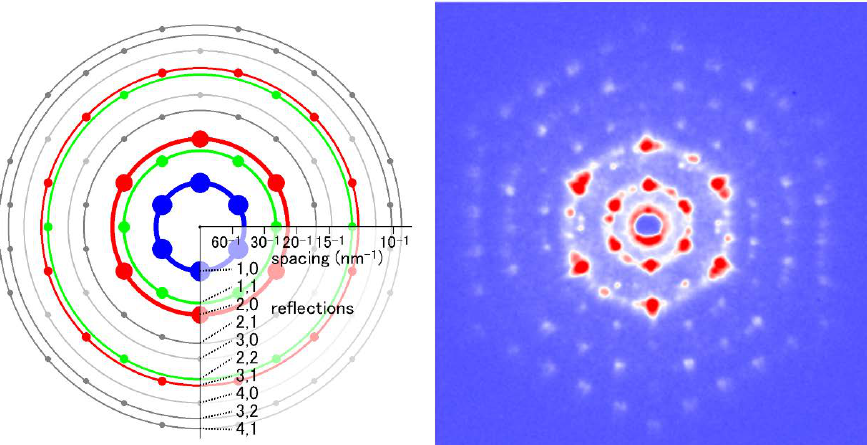
Figure 8. End-on diffraction pattern from a single myofibril of the flight muscle of a beetle, Aulacophora femoralis . The specimen was quick-frozen and the pattern was recorded at the liquid-nitrogen temperature. The left image is the schematic diagram showing the positions of the reflection spots expected from the hexagonal lattice of myofilaments. Taken from Reference [45].